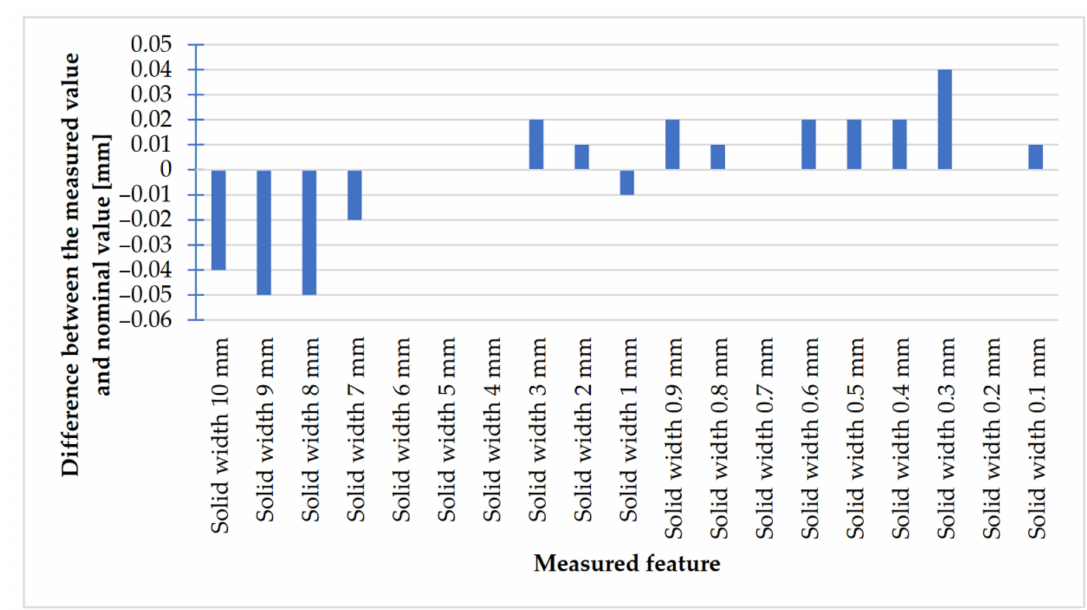
Figure 28. Deviation analysis for rectangular solids of variable width made in DMLS technology.